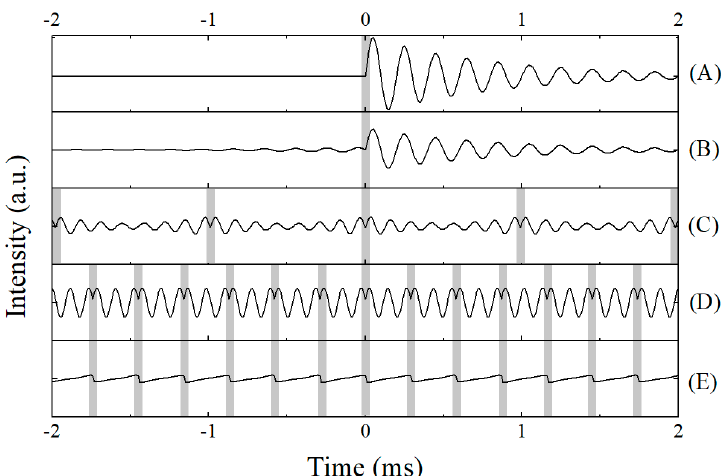
Figure 1. Nuclear magnetic resonance (NMR) signals simulated numerically using θ = 90°, T 1 = 200 ms, T 2 = 150 ms, T 2 * = 0.5 ms and several T p values. ( A ) T p = 5T 1 , ( B ) T p = T 2 , ( C ) T p = 2T 2 *, in ( D ) and ( E ) T p = 0.3 ms < T 2 *. The frequency offset is ( A – D ) 5.0 kHz and ( E ) 3.3333 kHz. Grey bars indicate the position of the applied